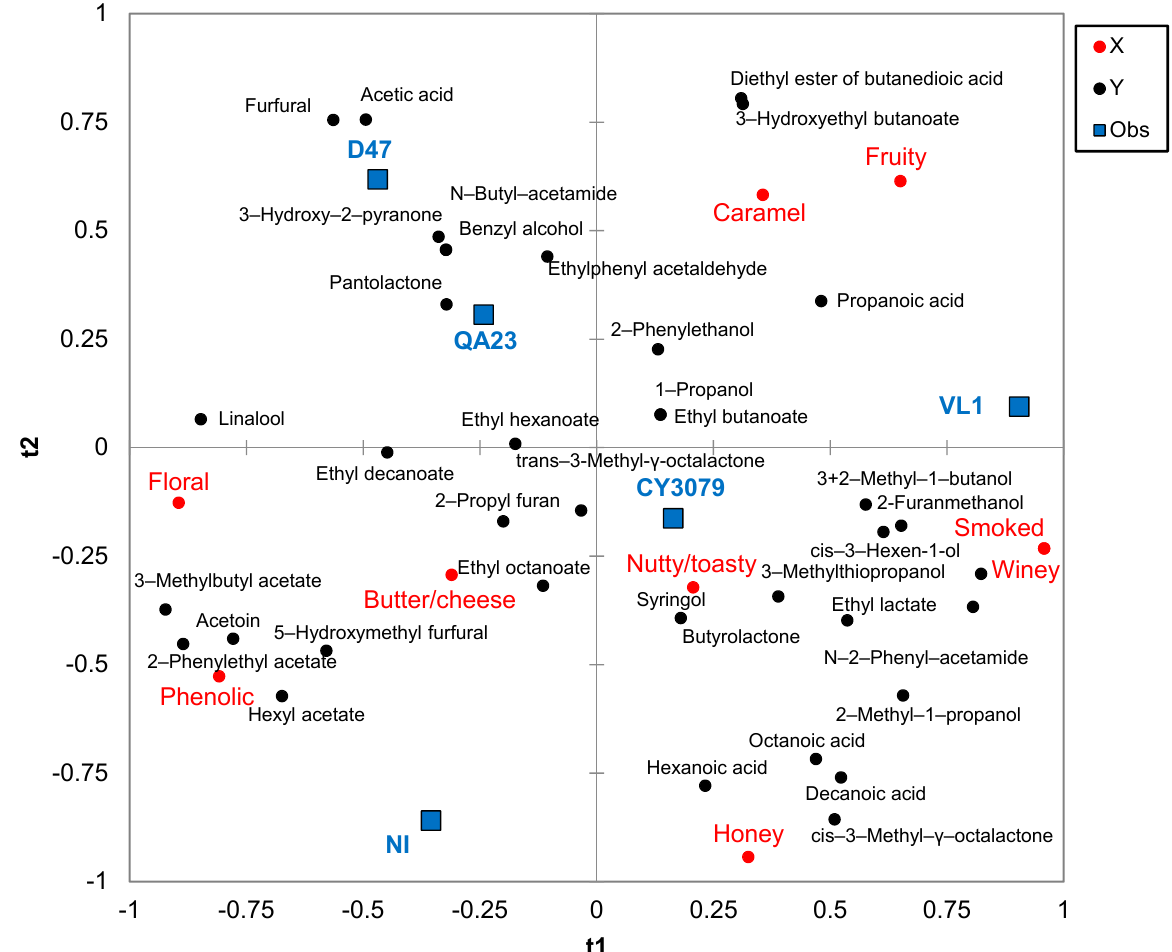
Figure 2. Plot of PLS regression analysis of volatile compounds and aromatic series in Fiano white wine fermented in barriques using four yeast strains. Only those volatile compounds having a statistically significant difference from ANOVA test were used for PLS. The attributes indicated in red are those resulting from the aromatic series obtained from GC/O analysis, while the observations are the different yeast strains used.